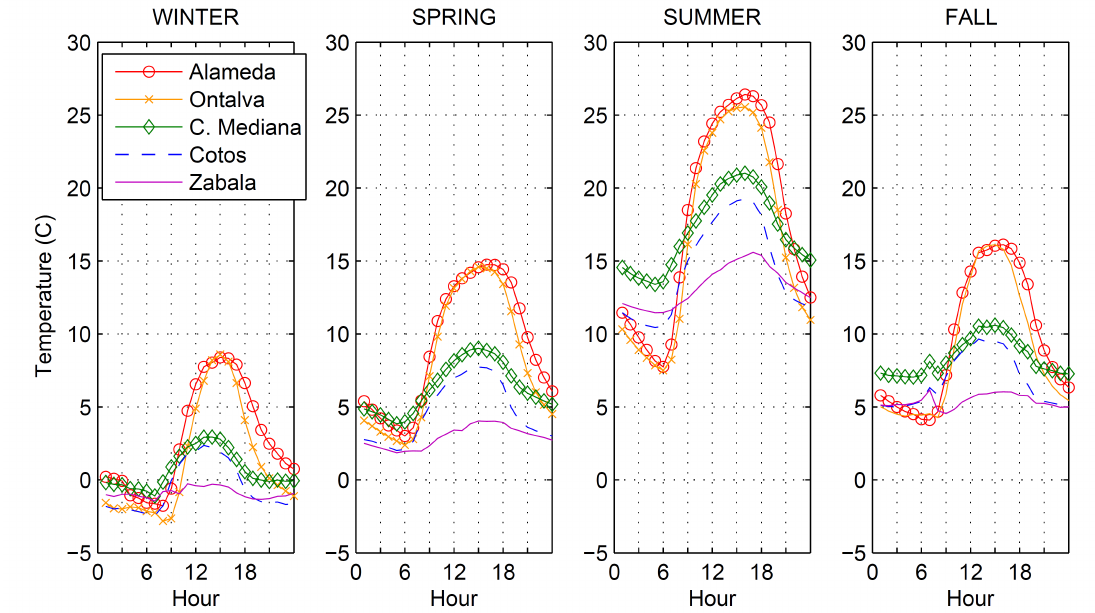
Figure 5. Mean hourly temperature for every site and season. Differences between maximum and minimum temperatures represent the mean seasonal temperature amplitude.